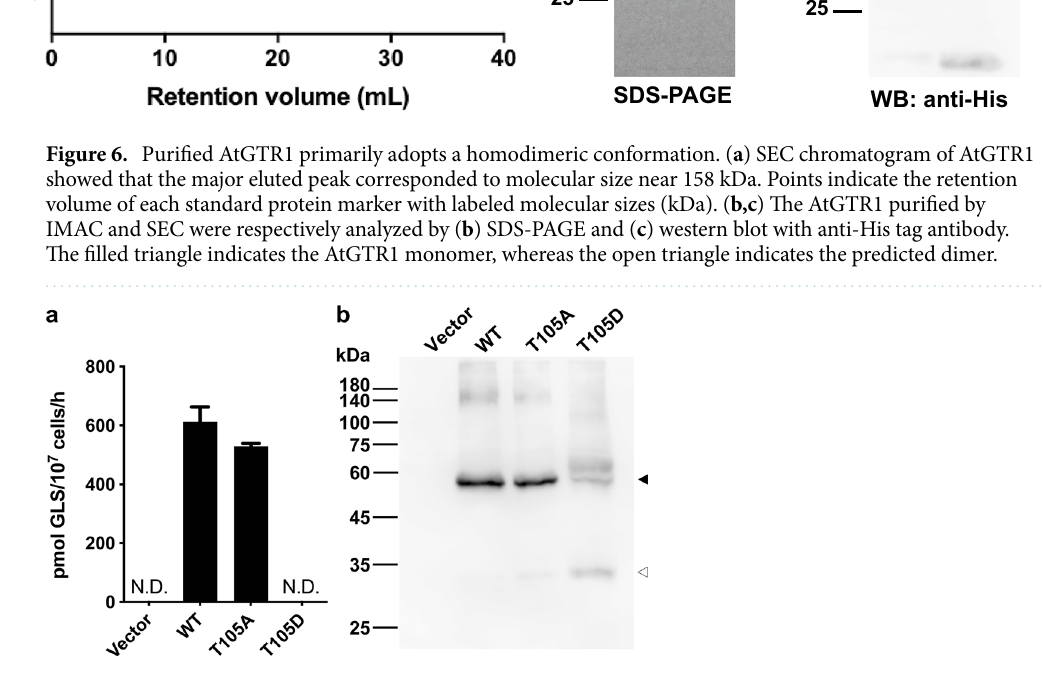
Figure 7. Phosphomimetic mutant of AtGTR1 lost GLS transport function and protein expression in yeast. ( a ) GLS transport activity of T105 mutants was determined by yeast uptake assay. The GLS uptake was quantified by RP-HPLC and showed as vertical bars with errors (mean ± SD, n = 3); N.D. indicates nondetectable. ( b ) Western blot of yeast cells expressing AtGTR1 and its T105 mutants. An anti-His-tag antibody was used as the primary antibody. The filled triangle indicates the AtGTR1 monomer, whereas the open triangle indicates degraded